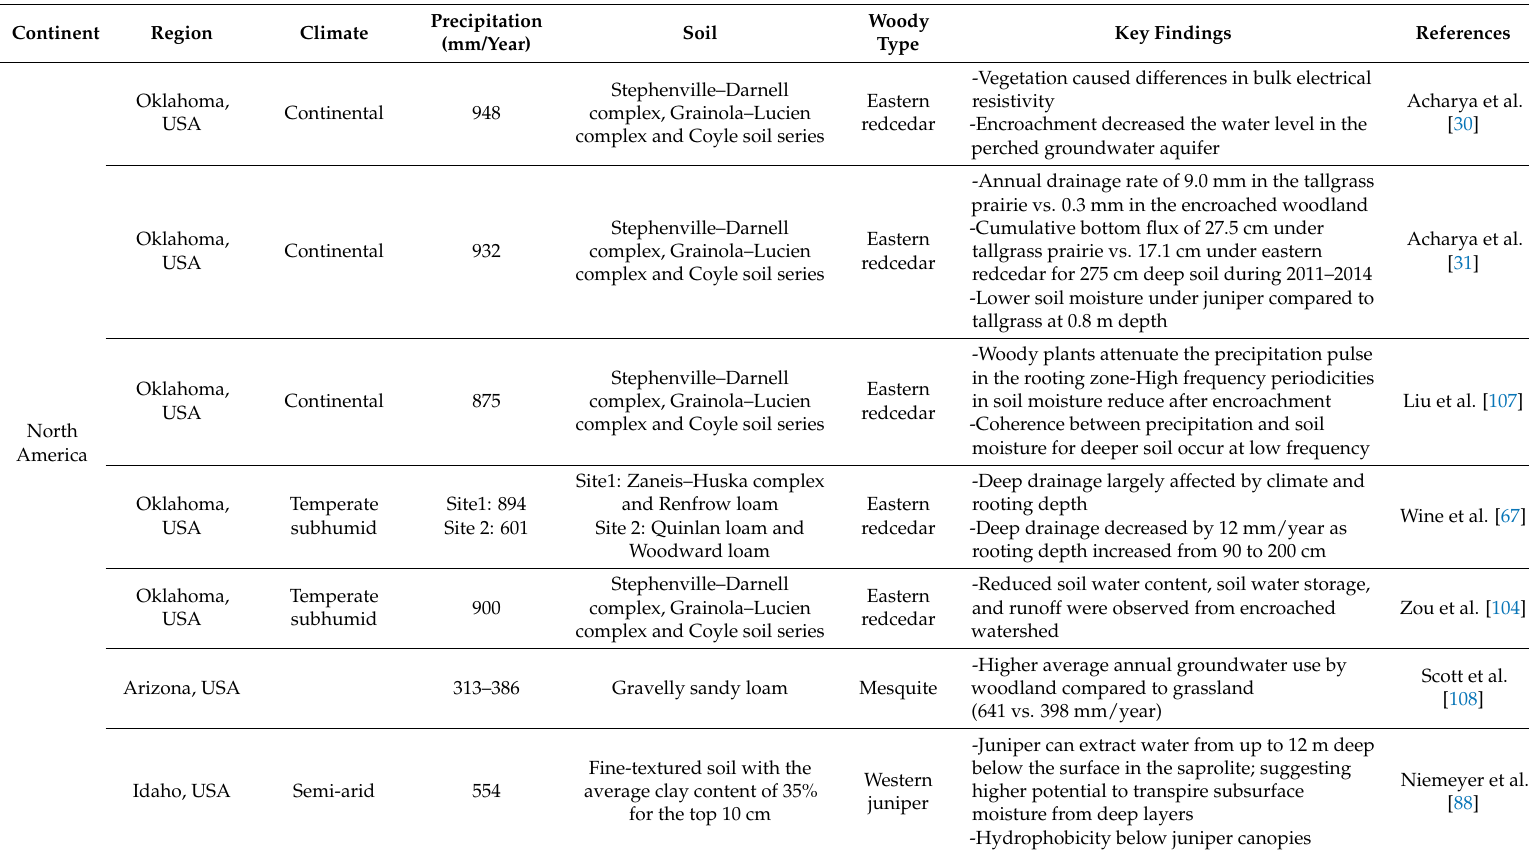
Table 3. Studies since 2012 reporting the impacts of woody plants on deep drainage and recharge across different location, climate and soil.